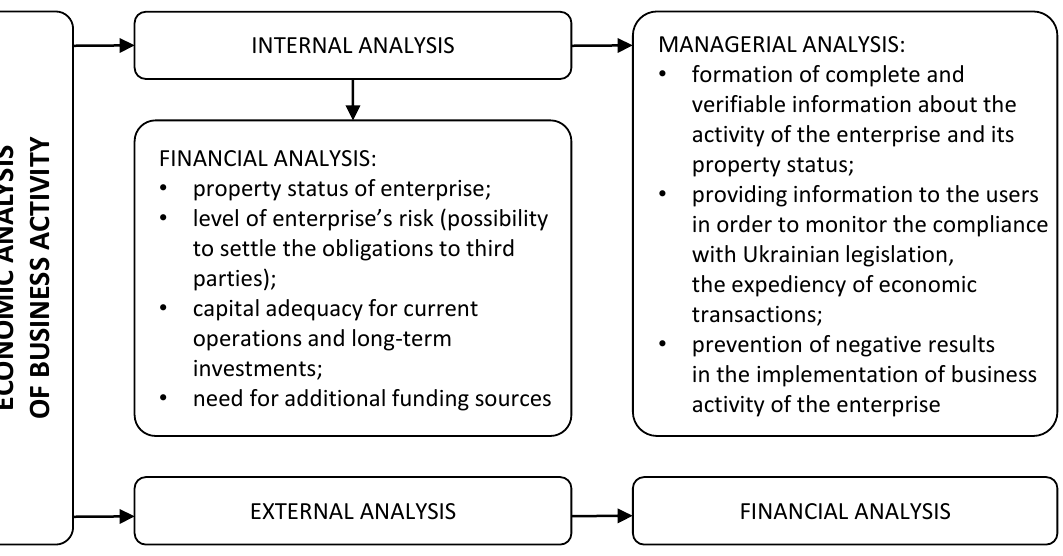
Figure 2. The scheme of displaying the place of management and financial analysis in the general system of analysis of economic activity of the